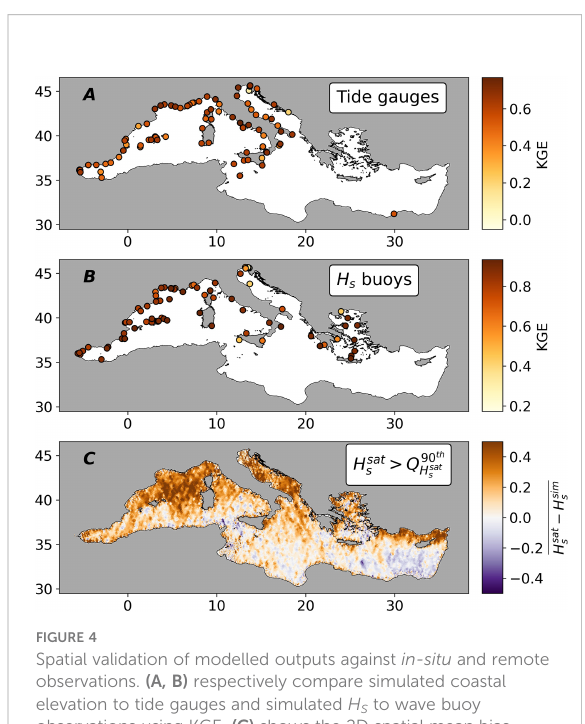
FIGURE 4 Spatial validation of modelled outputs against in-situ and remote observations. (A, B) respectively compare simulated coastal elevation to tide gauges and simulated H S to wave buoy observations using KGE. (C) shows the 2D spatial mean bias between wave satellite observations ( H sat S > 90 th quantile) and the corresponding simulated H S